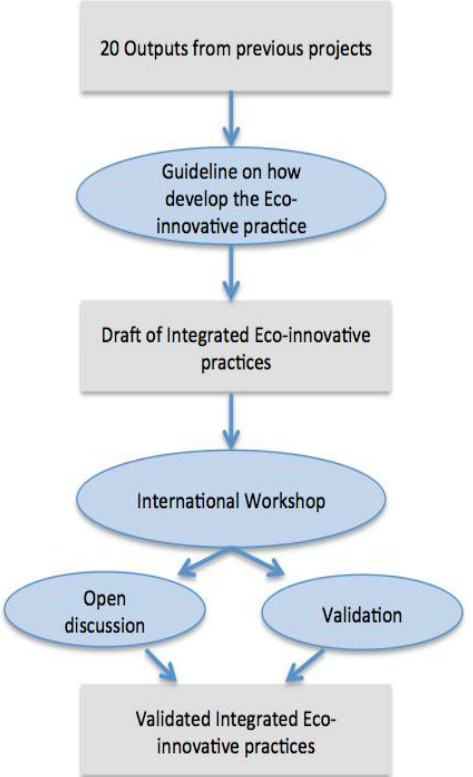
Figure 2. Methodological approach of the